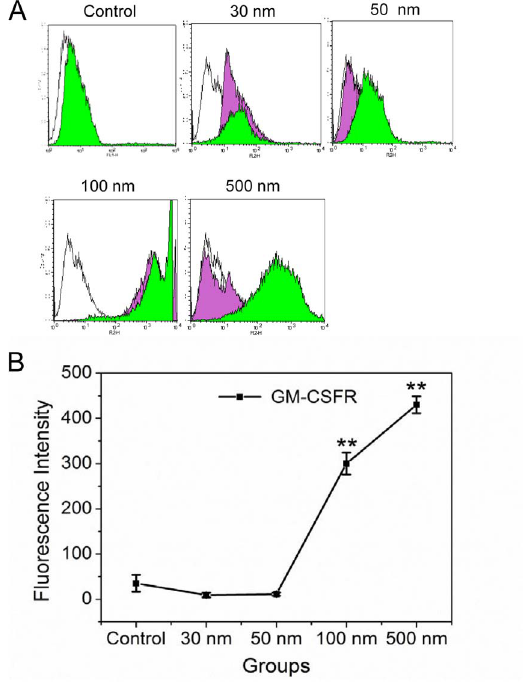
Figure 4. Flow cytometry assessment of CSF-1 receptor protein in RAW 264.7 cells. A) CSF-1 receptor expression on RAW 264.7 cell surface; the green histograms represent the fluorescence intensity of cells carrying NPs after immunofluorescence staining, white histograms depict control group cells without NPs, and the violet histograms indicate the fluorescence intensity of cells with only NPs. B) Line graph showing CSF-1 receptor expression in different pre-treated RAWs. ** p , 0.01 compared with control (Error bar is SEM).